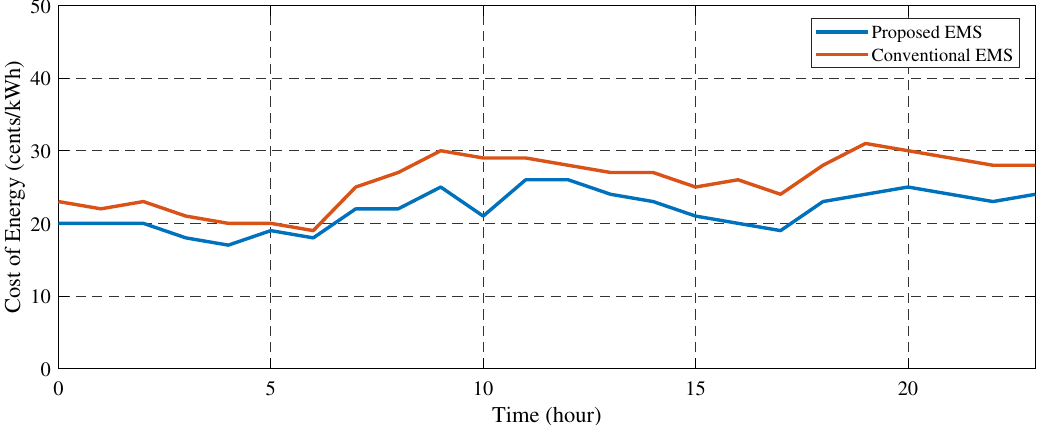
Figure 12. Cost of energy of the hybrid